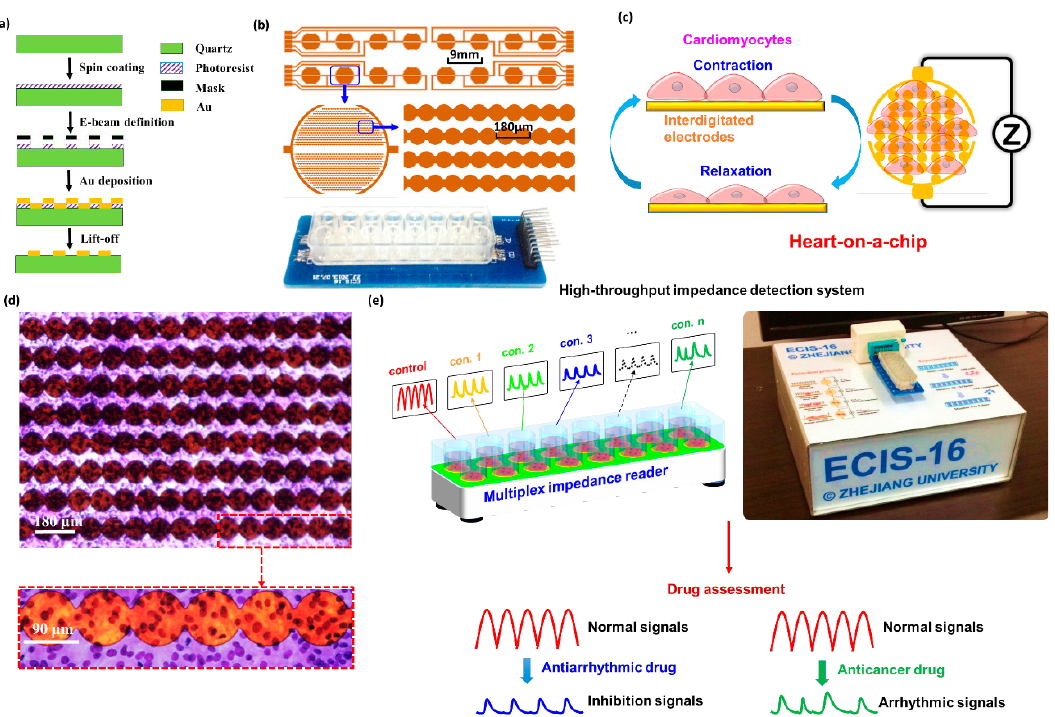
Figure 1. Establishment of heart-on-a-chip for drug assessment. ( a ) The fabrication of interdigitated electrodes (IDEs); ( b ) The IDEs layout and image of device; ( c ) Schematics of heart-on-a-chip with IDEs and impedance detection method; ( d ) The Diff-Quik staining images of cardiomyocytes on the device; ( e ) High-throughput impedance detection system for drug assessment using beating characteristics.